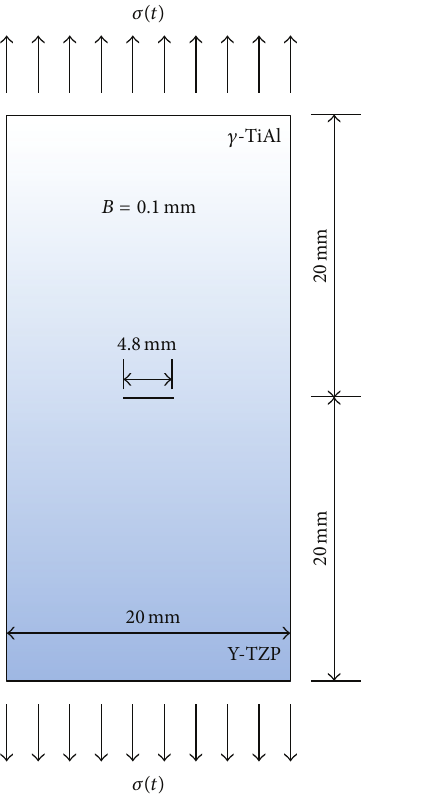
Figure 4: Center-crack functionally graded plate under impact loading.